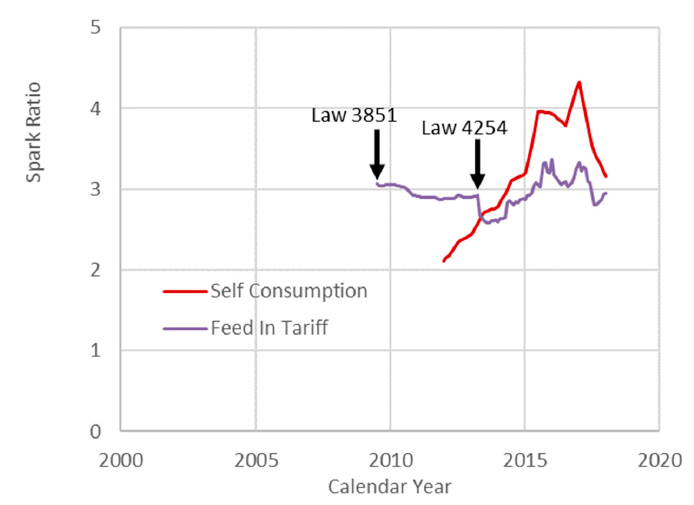
Figure 3. Spark ratio, Greece, 2002–2018.